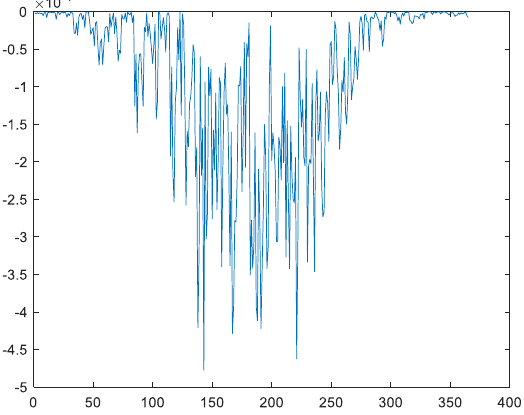
Figure 7. Onshore Daily effect of environment on degradation trend over one year.